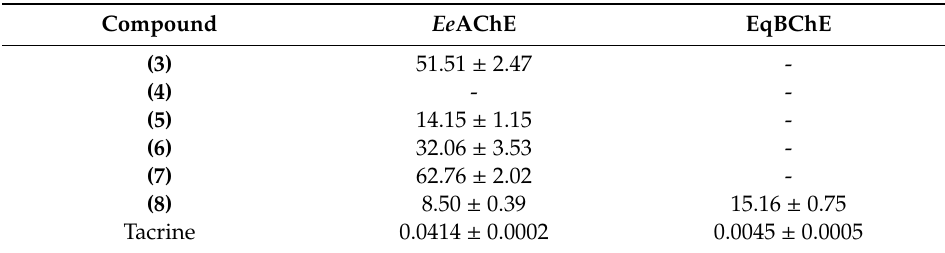
Table 2. IC 50 values, in µ M, of compounds (3) – (8) compared to tacrine.